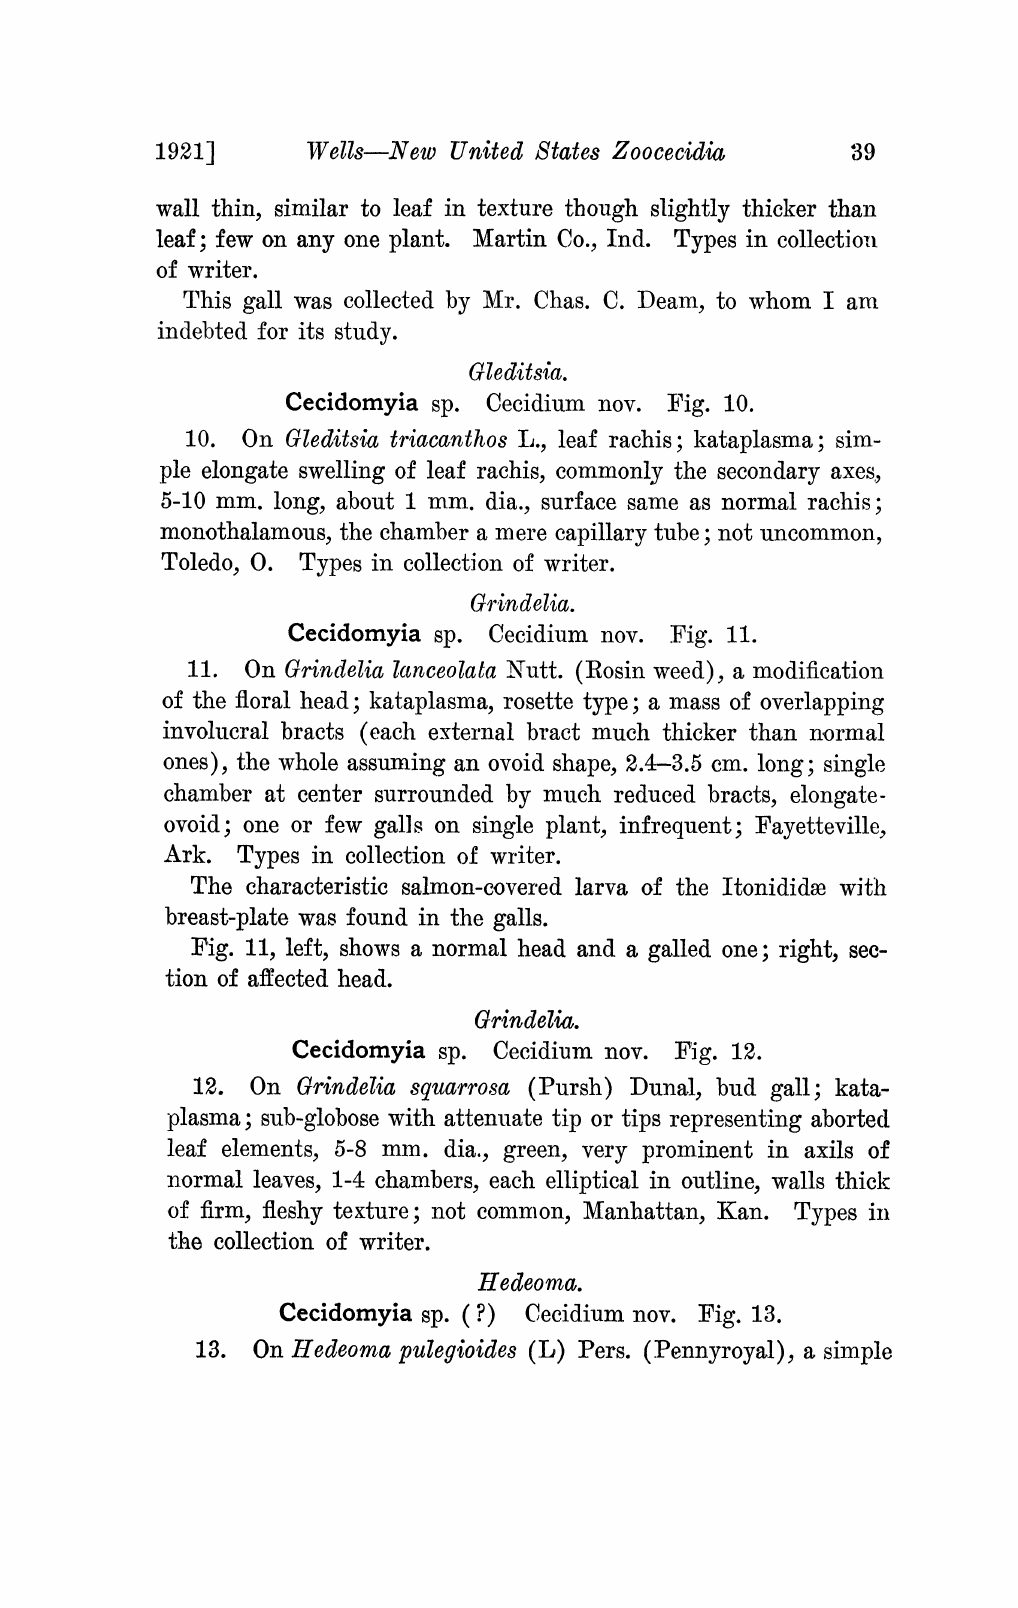
Cecidium nov. Fig.